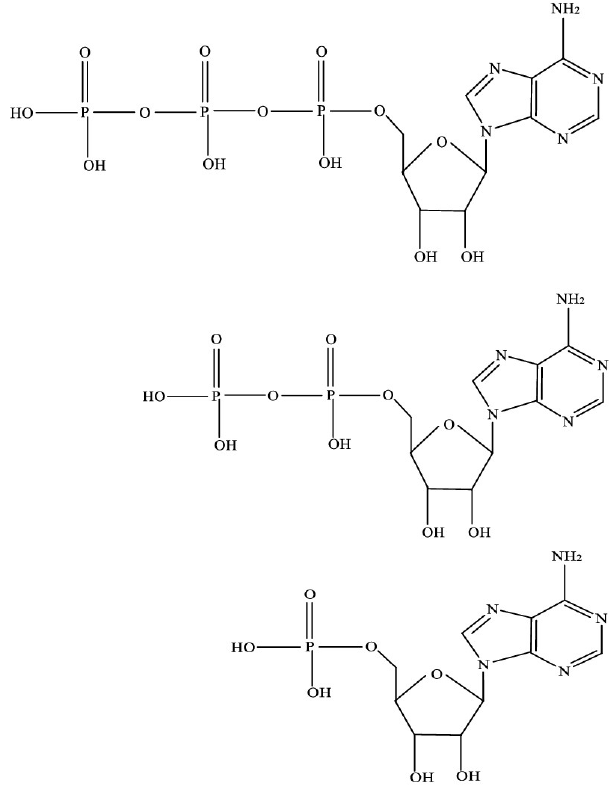
FIGURE 1 - Chemical structures of adenosine triphosphate (ATP), adenosine diphosphate (ADP), and adenosine monophosphate